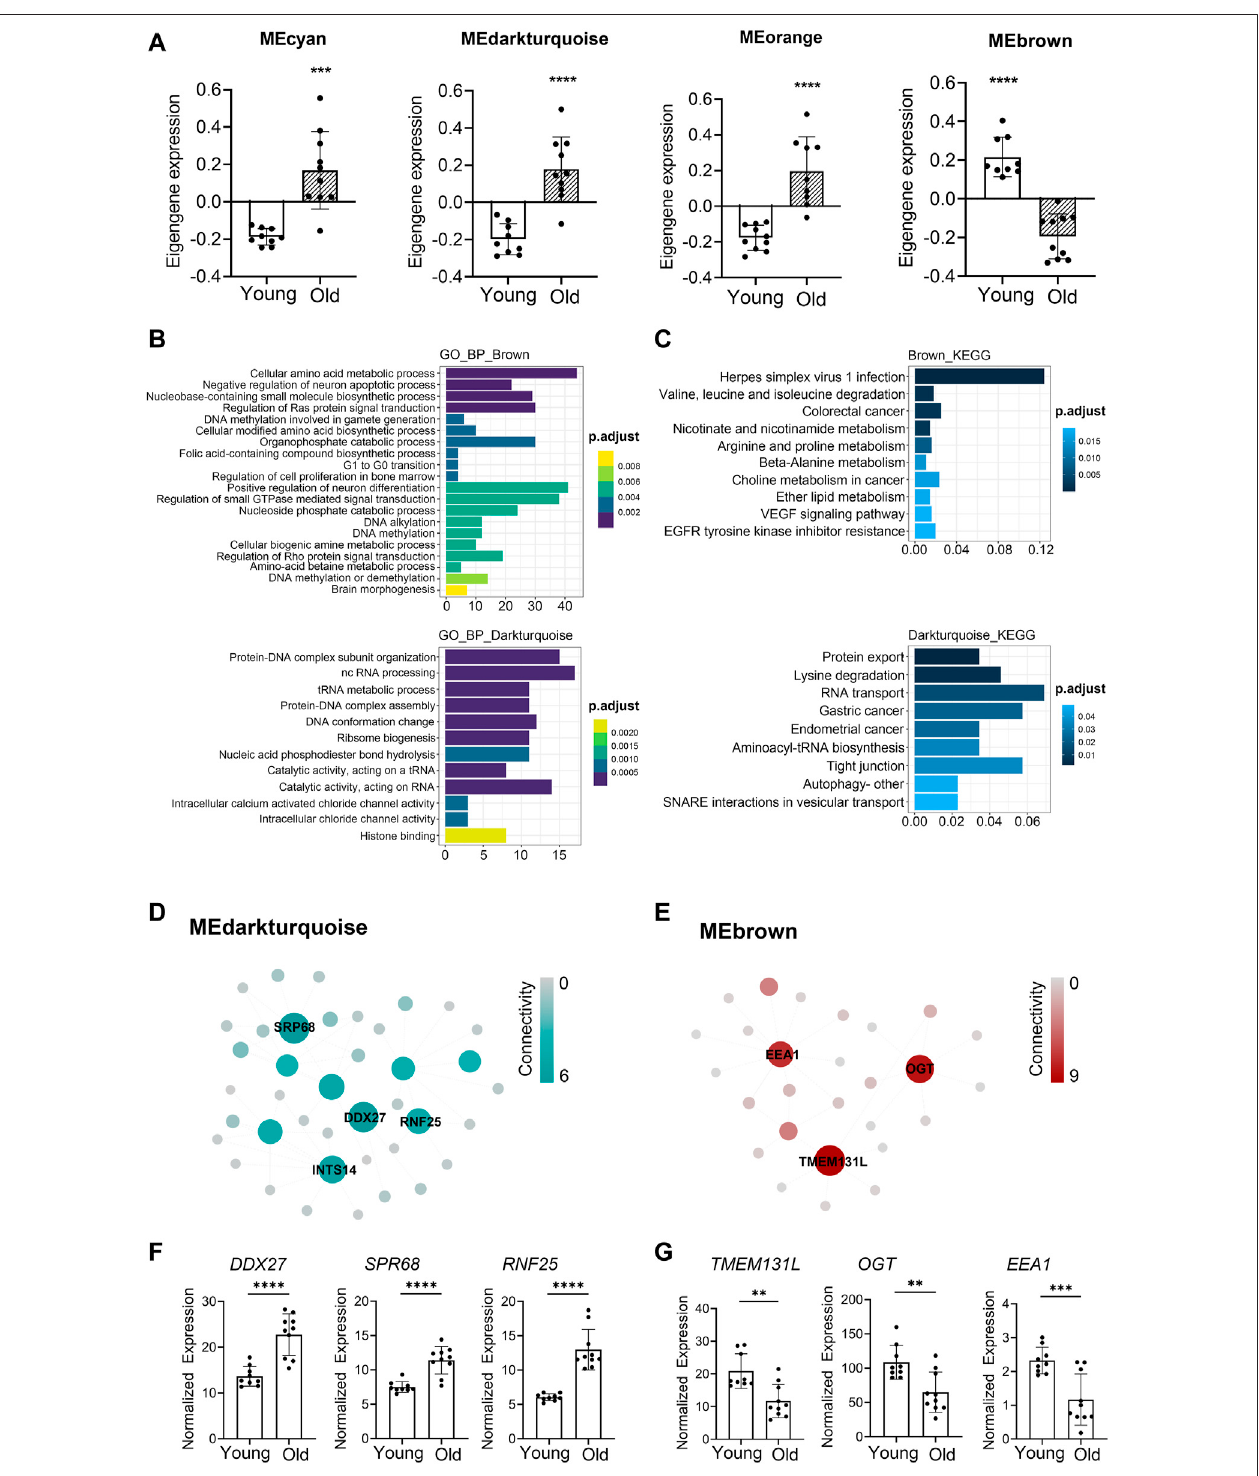
FIGURE 4 | Novel and known age-associated genes and pathways associated with PBMC aging in Asian (Chinese). Gene Ontology (GO) and KEGG pathway enrichment analyses were conducted to analyze the biological functions of modules. Module eigengene (ME) was de fi ned as the fi rst principal component of the expressionmatrixofthecorrespondingmoduleandwasconsideredasarepresentationofthegeneexpressionpro fi lesinamodule. (A) Thetranscriptomicexpressionof age related modules changed signi fi cantly among young and old individuals. Based on ME expression pro fi le of the four interesting modules, the expression of cyan, darkturquoise, and orange modules was downregulated, while brown module showed the opposite results. Box plots represent mean ± standard deviation (SD).